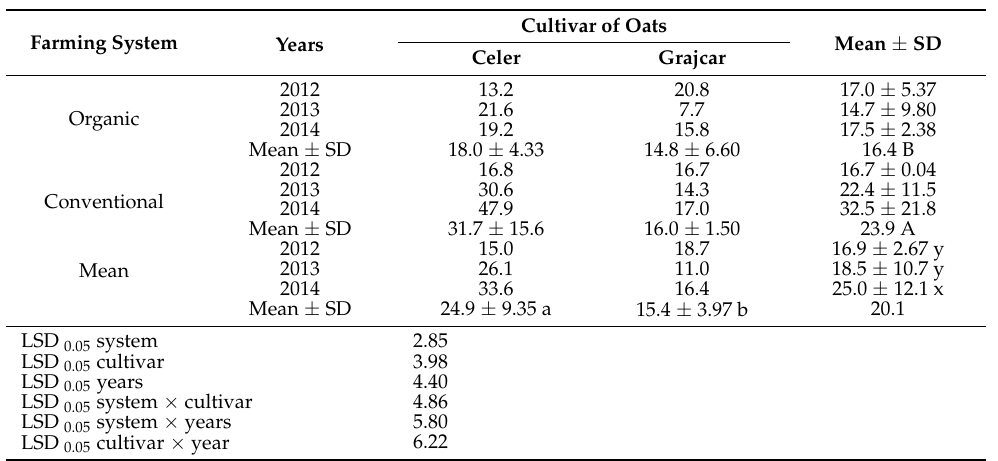
Table 7. The number of grains per oat panicle in the oat-vetch mixtures, depending on the farming system and oat cultivar in